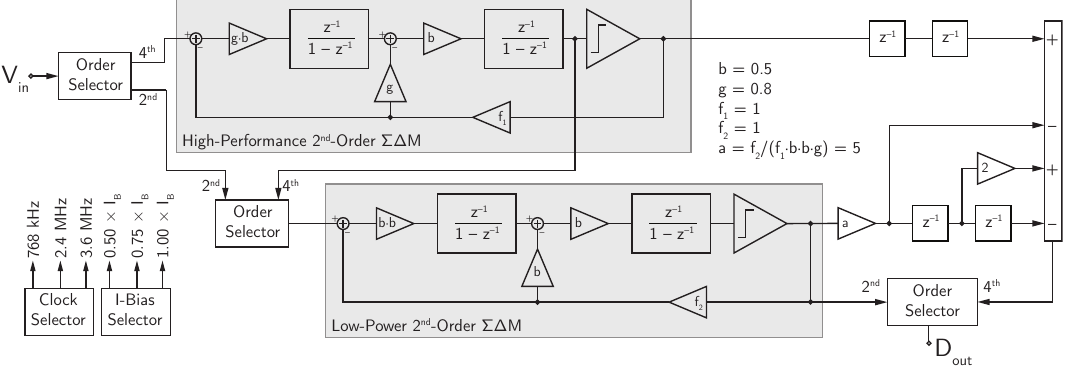
Figure 15. Block diagram of the reconfigurable DT MASH ΣΔ modulator (example 3).